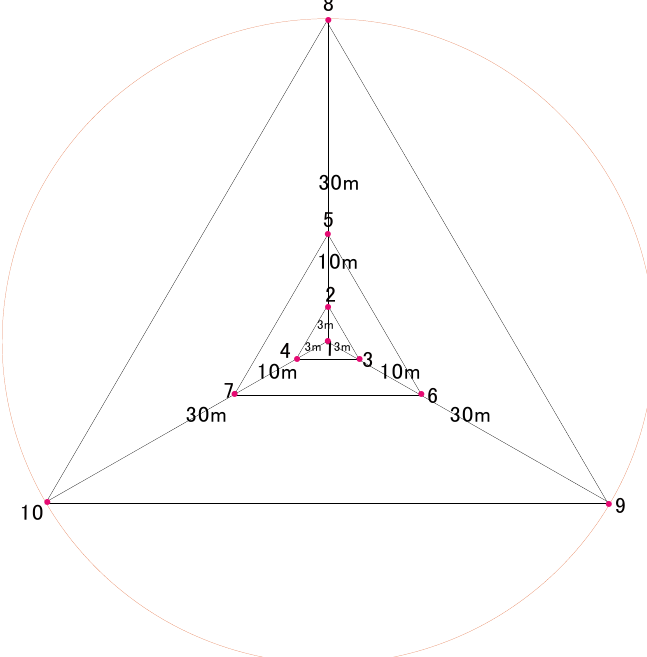
Figure 2. Geometry and size of radii for microtremor measurement. The 2-4-3 number represents a 3 m radius, and the numbers 5-6-7 and 8-9-10 represent radii of 10 m and 30 m, respectively.